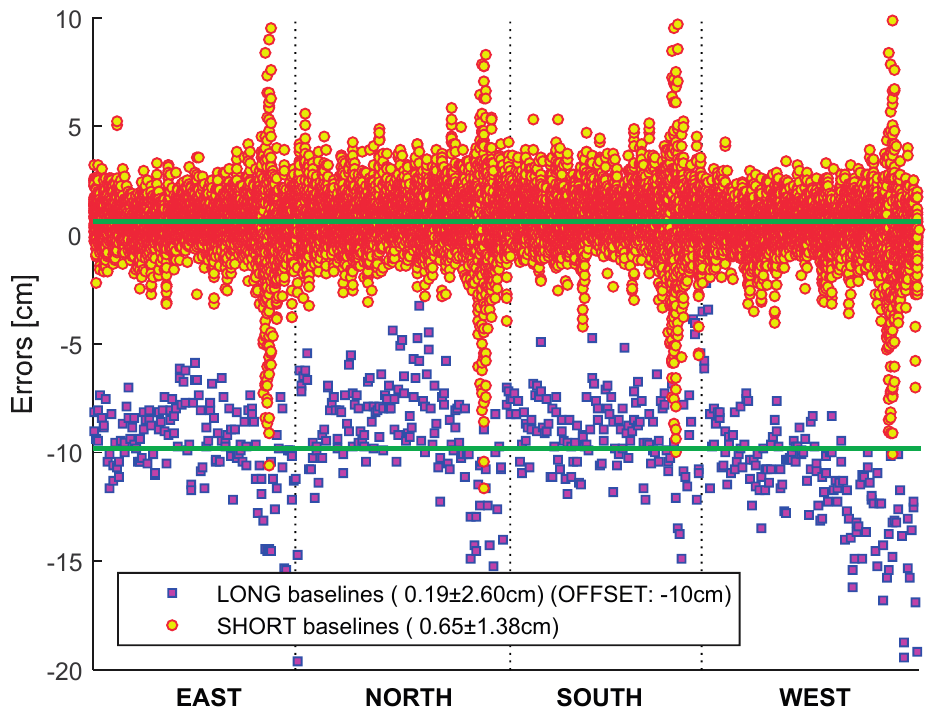
Figure 11. Effect of the baseline length on network RT. The long baselines are intentionally offset by 10 cm for